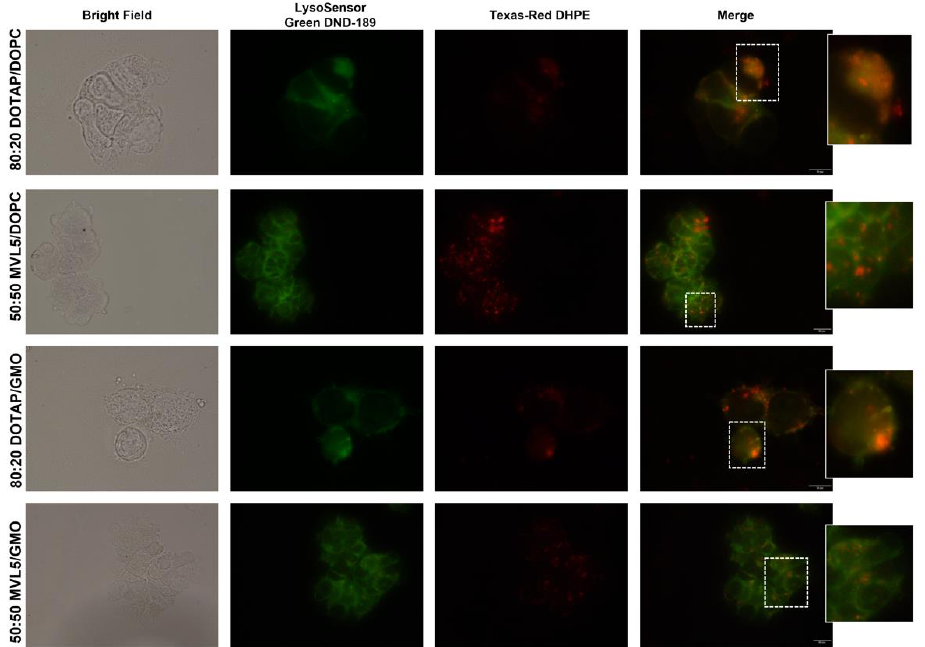
Figure 4. Colocalization of DOTAP and MVL5 lipoplexes signal (red) with LysoSensor (lysosome marker, green) after 4 h of transfection. HEK 293T cells were transfected with Texas-Red-DHPE labeled lipoplexes for 4 h at 37 °C, and then stained with LysoSensor to track the lysosomes ’ location. Merged files are representative of the colocalization of CL-DNA complexes with lysosomes. Images were obtained by fluorescence microscopy using a 60× and 100× immersion oil objective. Scales bar corresponds to 10 and 20 µm.